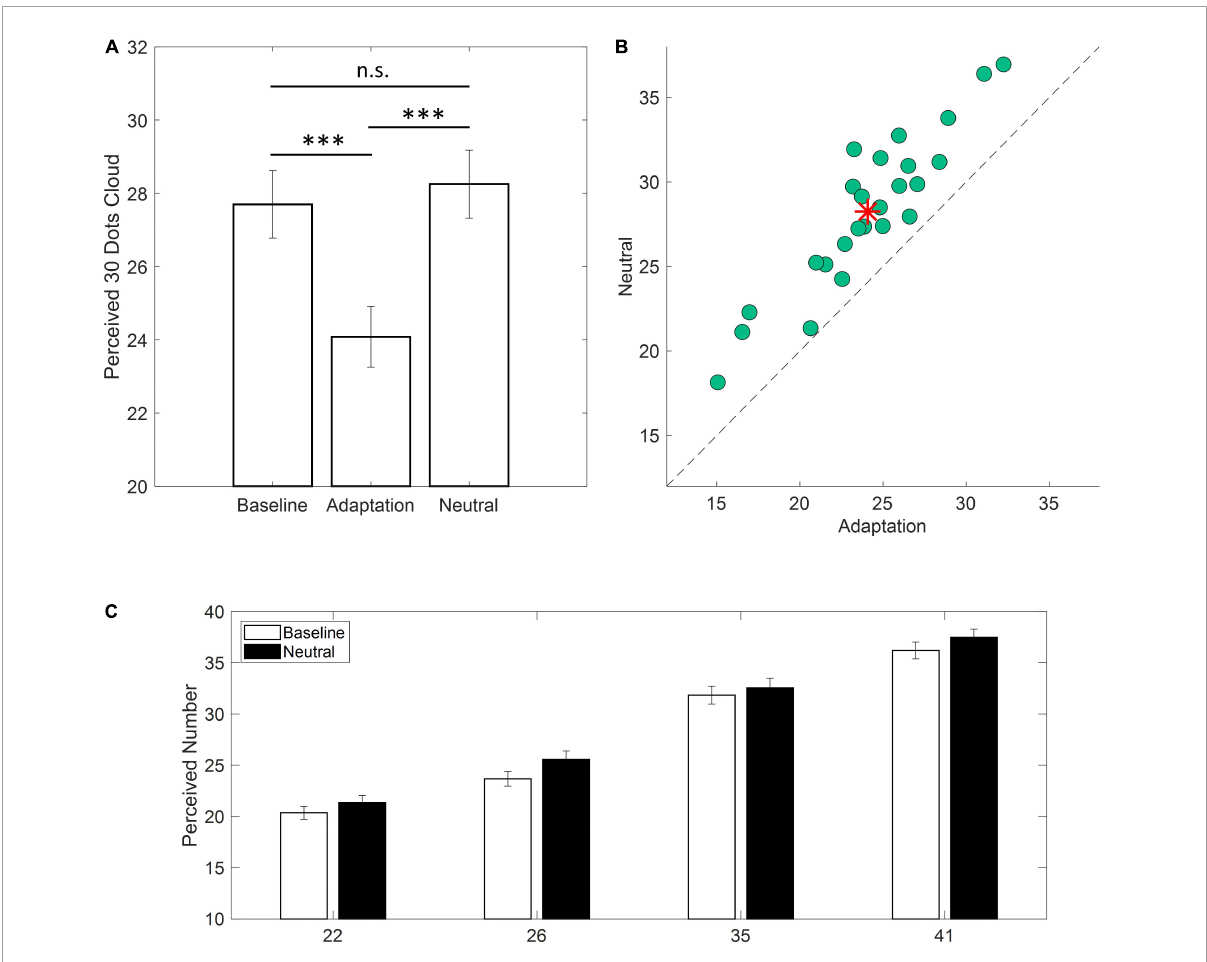
FIGURE2 Behavioral results. (A) Average estimates of a cloud of 30 dots in the three experimental conditions (i.e., Baseline, Adaptation, Neutral). Error bars are ± 1 SEM (*** p < 0.001). (B) Scatterplot depicting single participants responses in the Adaptation condition against the Neutral condition. Data falling above the equality line indicate lower estimation values for the Adaptation condition. Red asterisk indicates the average across participants. (C) Average estimates for clouds containing 22, 26, 35, or 41 dots for the Baseline and Neutral conditions (white and black bars, respectively). Error bars are ± 1